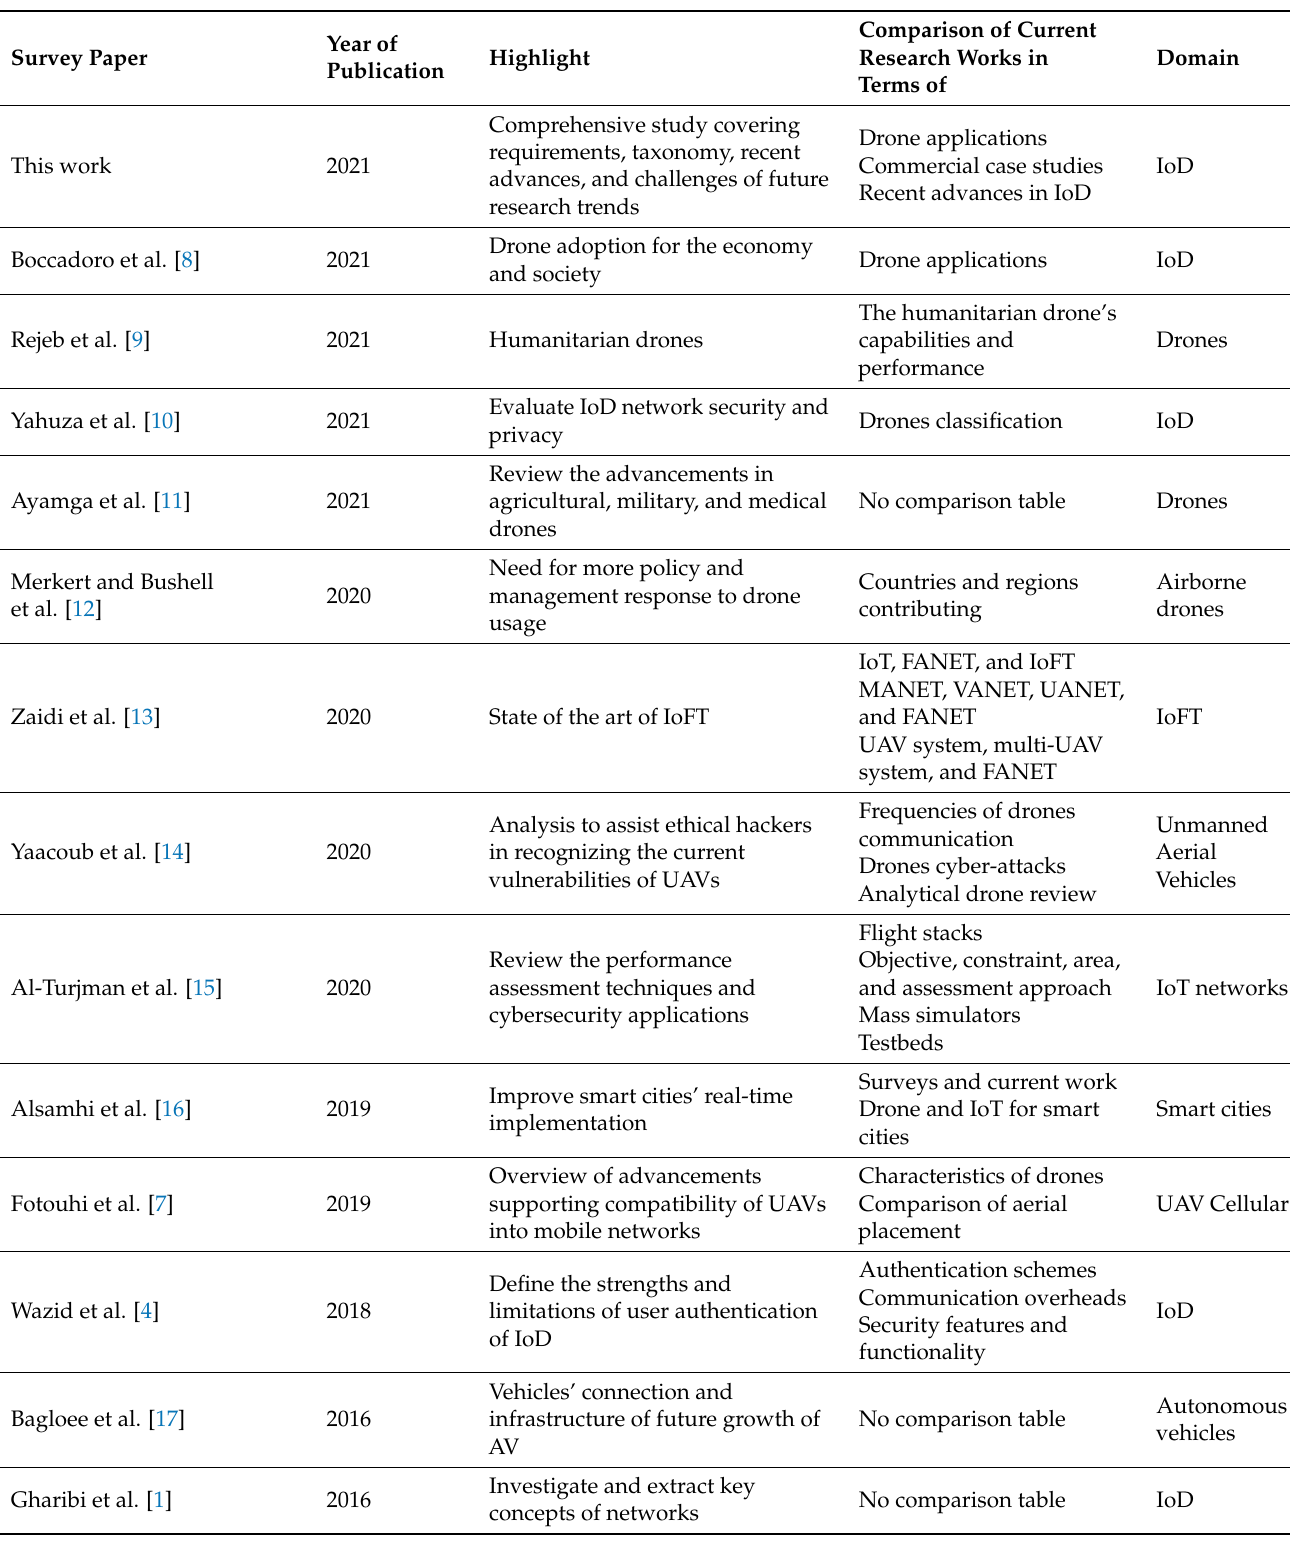
Table 1. Related